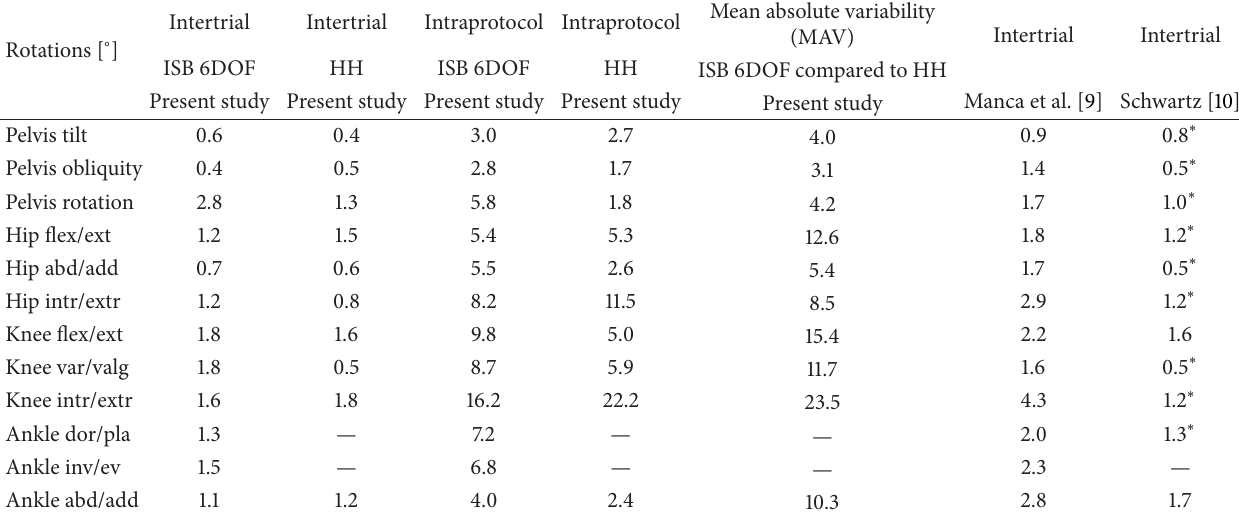
Table 1: Average intertrial, intraprotocol variability and mean absolute variability over the gait cycle across four subjects. Corresponding values from Manca et al. [9] and Schwartz et al. [10]. ∗ Data estimated from figures provided.